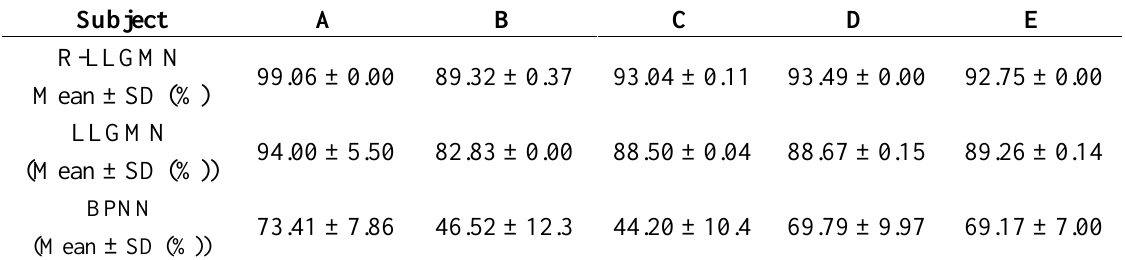
Table 5. Discrimination results of five subjects (A, B, C, D and E)